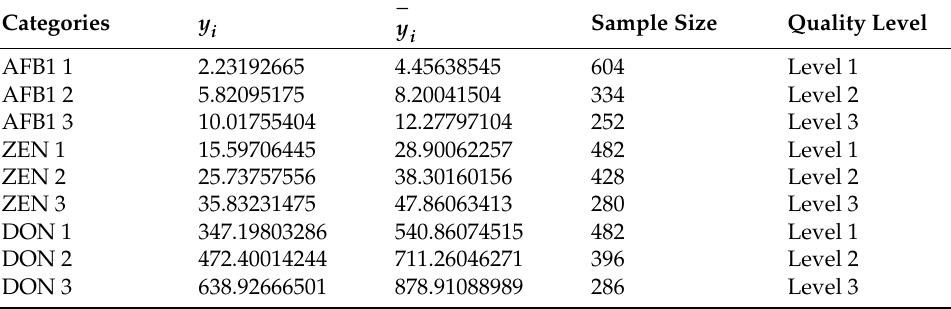
Table 6. Clustering centers and ranking of three clusters of